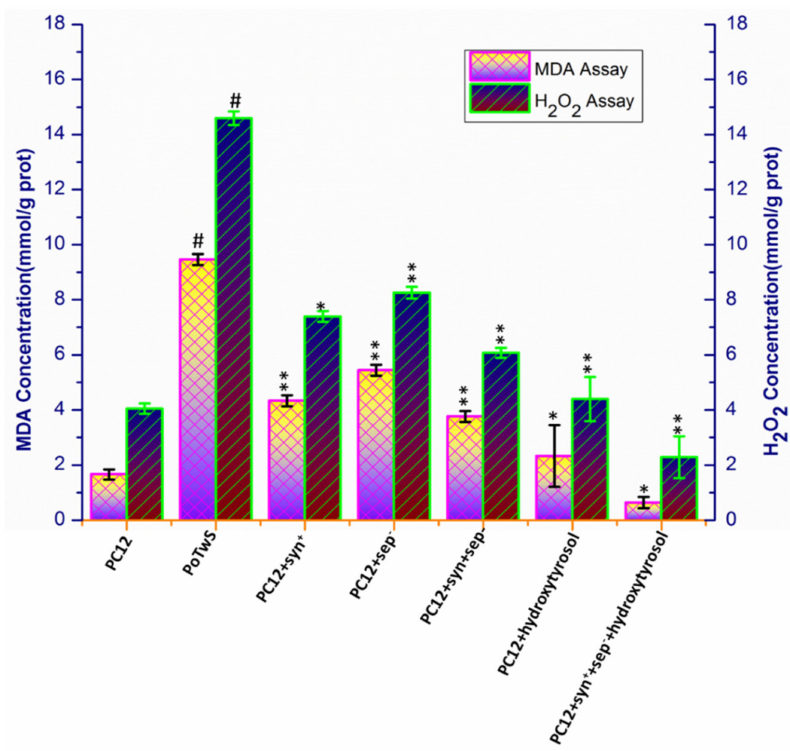
Figure 3. Determination of MDA and H 2 O 2 levels. The levels of MDA and H 2 O 2 were increased in PoTwS cells compared to PC12 cells (without any treatment). The PC12 + syn + + sep − + hydroxytyrosol cell line displayed the lowest levels of MDA and H 2 O 2 compared to PoTwS cells. The PC12 + hydroxytyrosol and PC12 + syn + + sep − + hydroxytyrosol cell lines were pretreated with 100 µ M of hydroxytyrosol for 12 h. The description of each cell line is given in the Supplementary Table S3. Data are mean and S.E. values from three independent experiments ( n = 3). # p < 0.01, relative to PC12 (control cells). * p < 0.05 and ** p < 0.01, relative to the cells treated only with